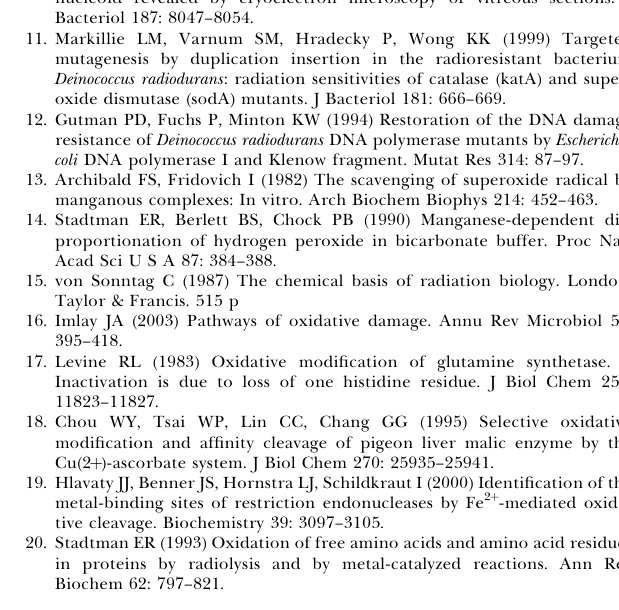
Figure S2. Oxidation of Mn(II) during c -Radiolysis of Water ( 60 Co, 0 8 C) Column I. 1 M MnCl 2 , no IR (aerobic); II. 1 M MnCl 2 þ 10 kGy (aerobic) (30 min after IR). Red-brown color indicates Mn(III); III. 1 M